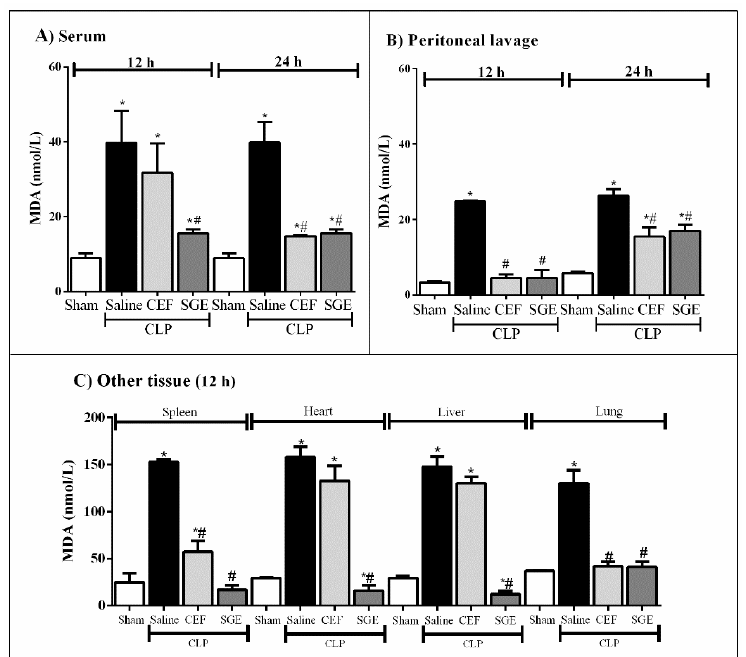
Figure 7. Effect of SGE on lipid peroxidation products in septic mice. ( A ) MDA levels in serum at 12 and 24 h after CLP. ( B ) MDA levels in the peritoneal cavity 12 and 24 h after CLP. ( C ) MDA levels in other tissue 12 h after CLP. The results are expressed as the mean ± SD (five animals/group). * p < 0.05 compared to the sham group; # p < 0.05 compared to saline-pretreated septic group. CLP: cecal ligation and puncture; SGE: salivary gland extract; CEF: ceftriaxone; MDA: malondialdehyde.